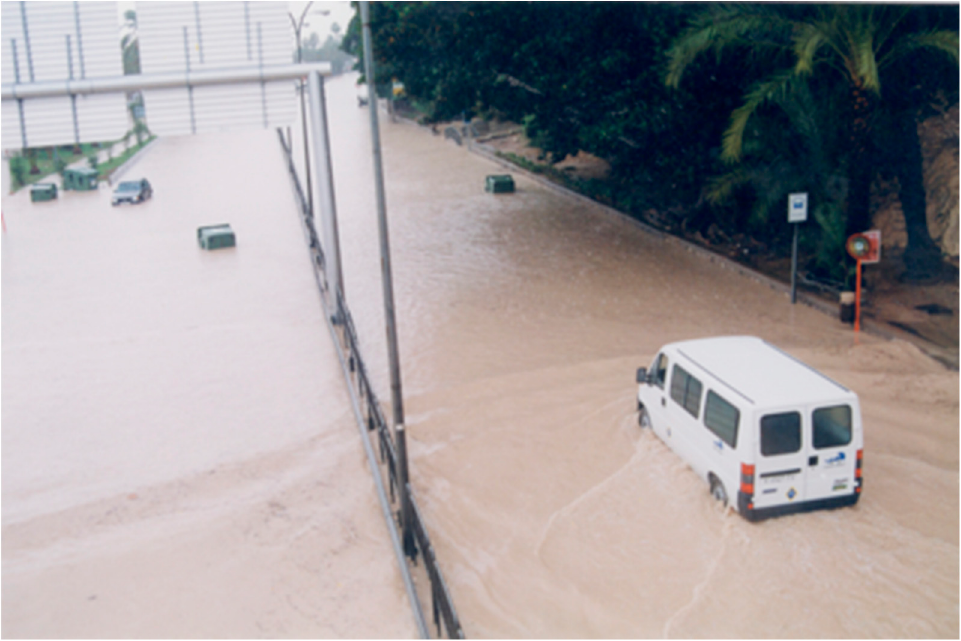
Figure 3. Flooding of Denia Avenue due to the overflowing of the Bonhivern ravine (29 September 1997). Source: Authors.